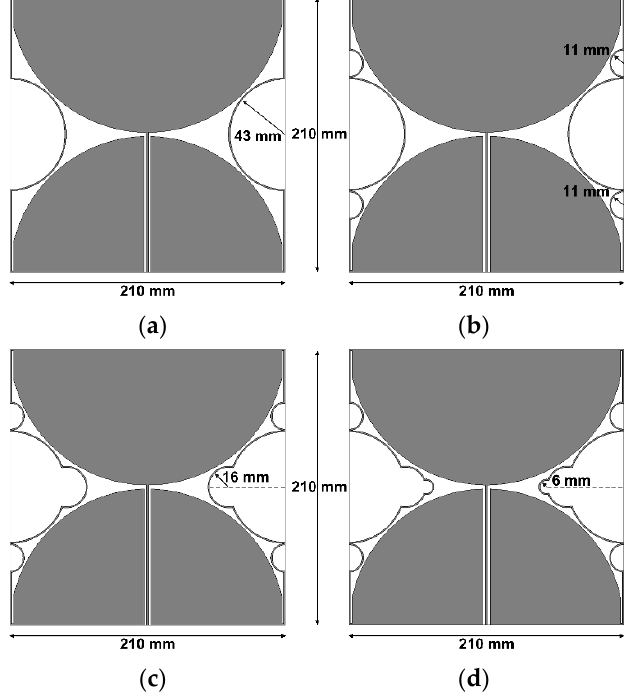
Figure 4. Detailed design process for the multiple half-circular-ring-based loop structure: ( a ) the original antenna with the first half-circular rings; ( b ) the original antenna with the first and second half-circular rings; ( c ) the original antenna with the first, second, and third half-circular rings; ( d ) the original antenna with the first, second, third, and fourth half-circular rings.